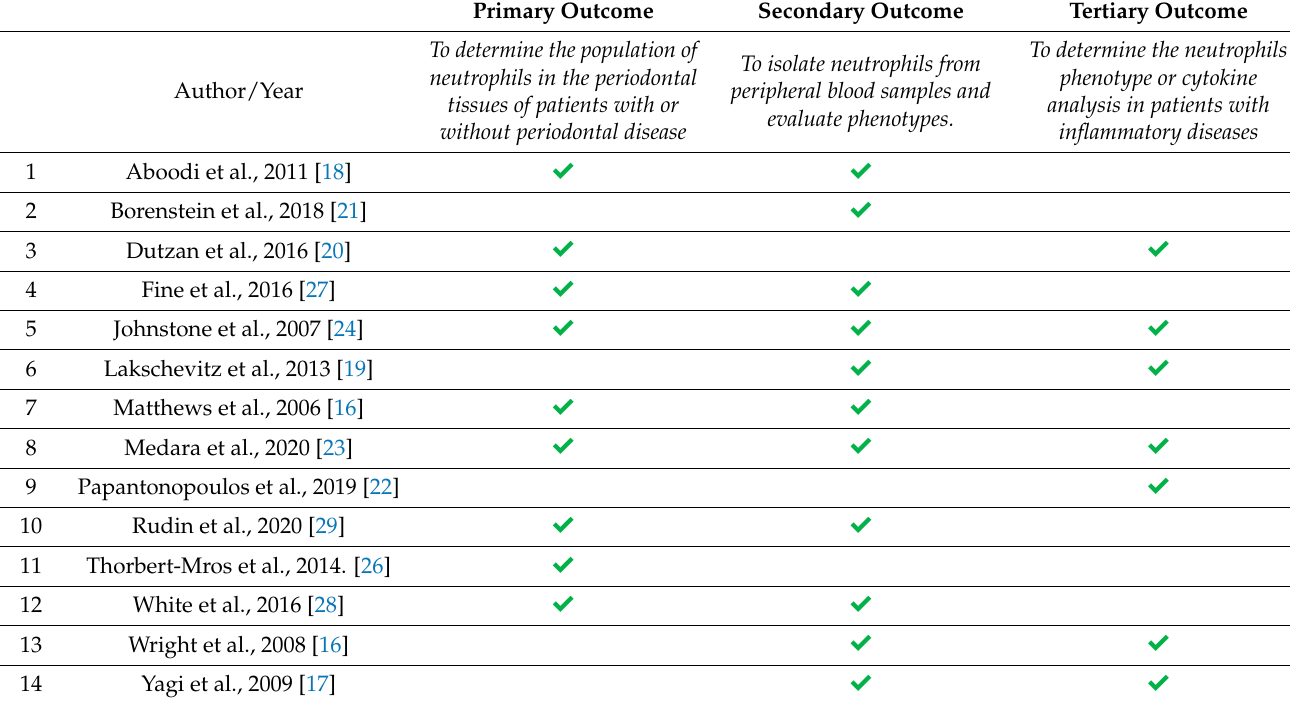
Table 2. Contribution of the selected studies to the outcome.